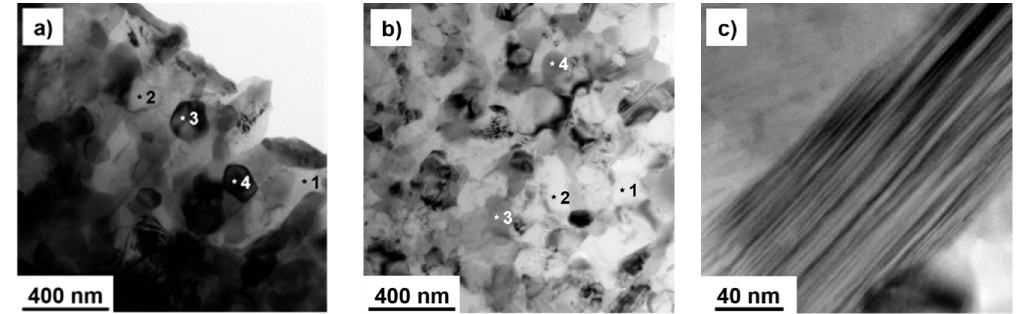
Figure 5. Bright field TEM micrographs of MA + SPS: ( a ) Al-20Si-10Fe-6Cr; and ( b ) Al-20Si-10Fe-6Mn alloys with marked points of EDS X-ray analysis (TEM + EDS); and ( c ) more detailed view of the stacking fault present in intermetallic phases of the Al-20Si-10Fe-6Mn alloy. Table 2. Chemical compositions (at %) given by the TEM + EDS point analysis of the present phases in MA + SPS Al-20Si-10Fe-6Cr and Al-20Si-10Fe-6Mn alloys. Alloy (Preparation) Element (at %) Corresponding Phase Point